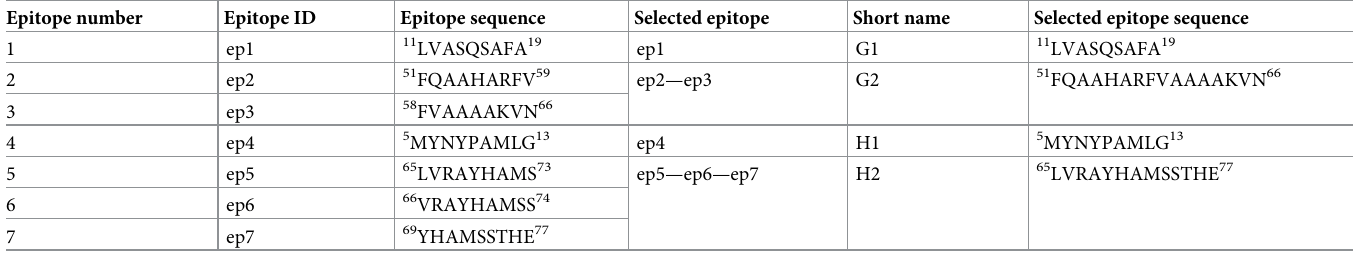
Table 1. Epitopes selected. Amino acid sequence from epitopes selected of protein EsxG and